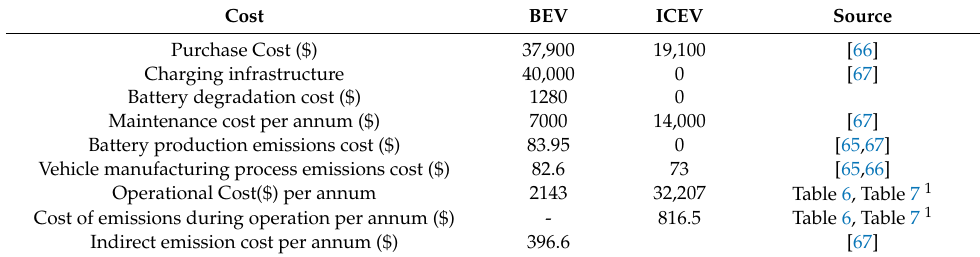
Table 8. Life cycle cost assessment of BEVs and internal combustion engine vehicles (ICEVs).